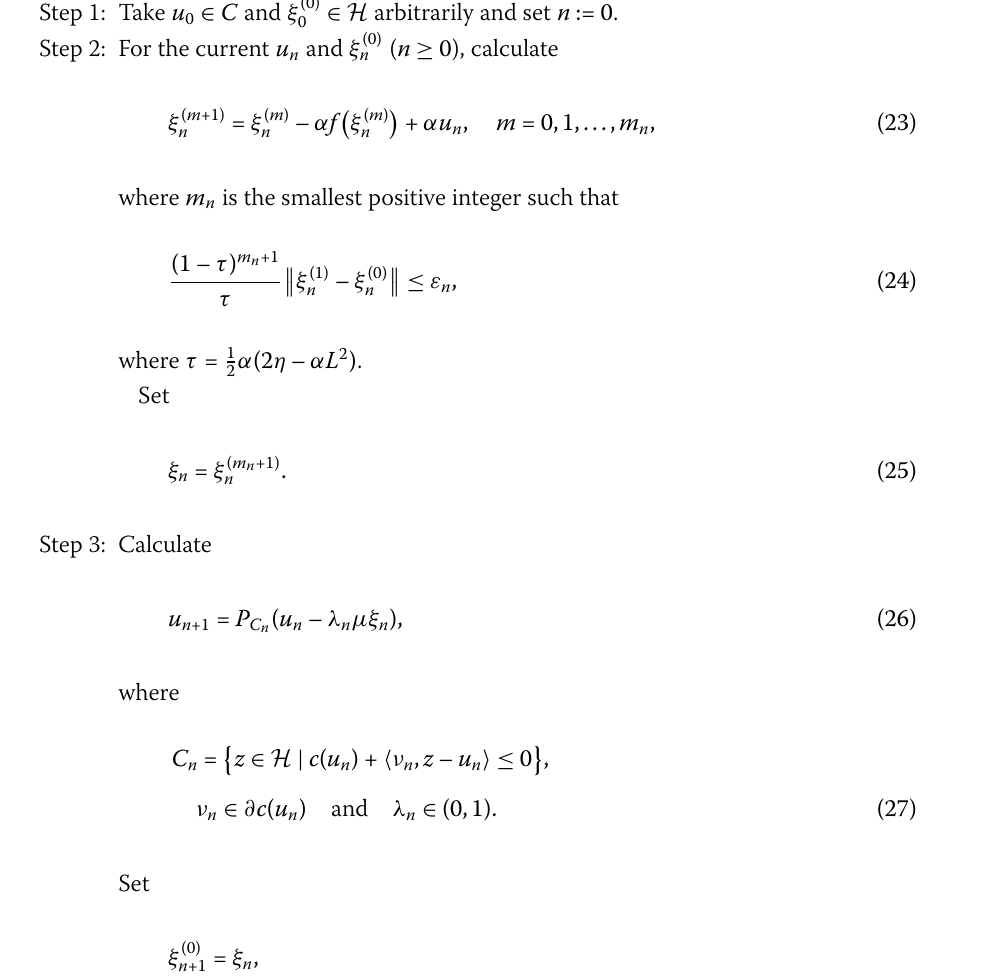
Algorithm 5.1 (The alternating contraction relaxation projection